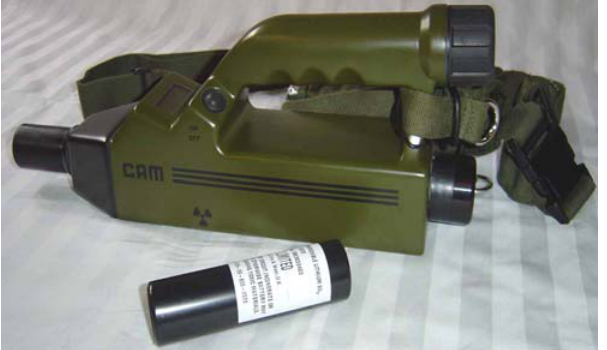
Figure 5 – Monitor of chemical agents CAM Рис . 5 – Газосигнализатор CAM Слика 5 – Монитор хемијских агенса